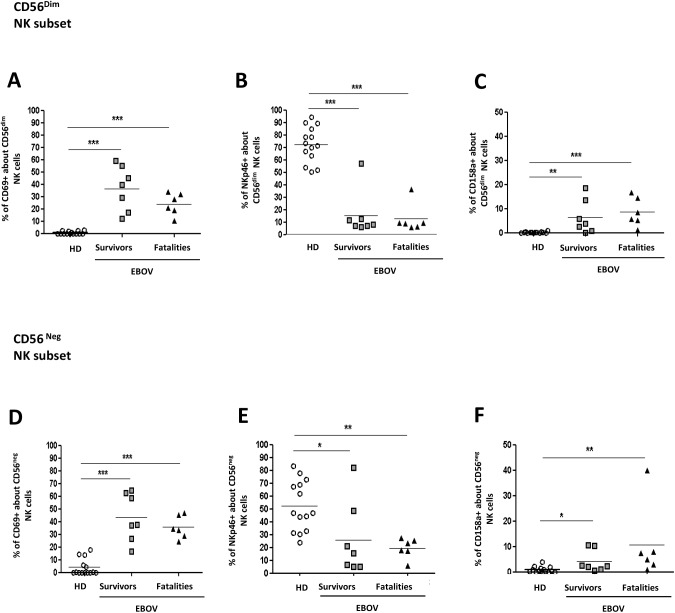
NK cells phenotype in survivors and in fatalities.The frequency of CD56dim NK cells expressing CD69pos (A), NKp46pos (B) and CD158a pos (C) was analyzed in HD (n = 14), EBOV-survivors (n = 8) and EBOV-fatalities (n = 6). The frequency of CD56neg NK cells expressing CD69pos (D), NKp46pos (E) and CD158apos (F) was analyzed in HD (n = 14), EBOV-survivors (n = 8) and EBOV-fatalities (n = 6). Statistical analysis was performed by using Mann Whitney test and differences were considered significant with a p<0.05, and highlighted with an asterisk. *: p<0.05; **: p<0.01; ***: p<0.001.